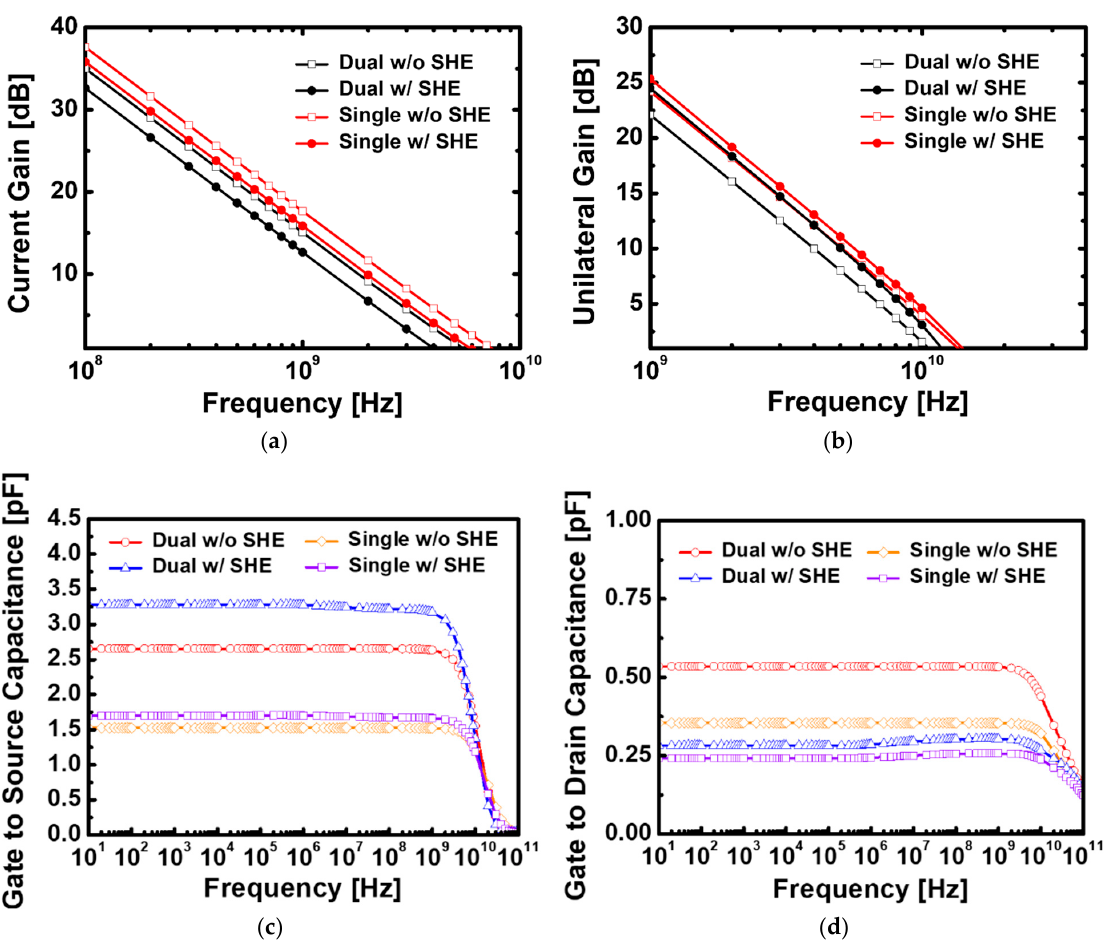
Figure 9. ( a ) Cut-off frequency, ( b ) maximum frequency and dependence of ( c ) gate to source capacitance and ( d ) gate to drain on frequency for the recessed-gate GaN MOSFET using the stacked TiO 2 /Si 3 N 4 dual-layer insulator and Si 3 N 4 single-layer insulator with and without self-heating effect.